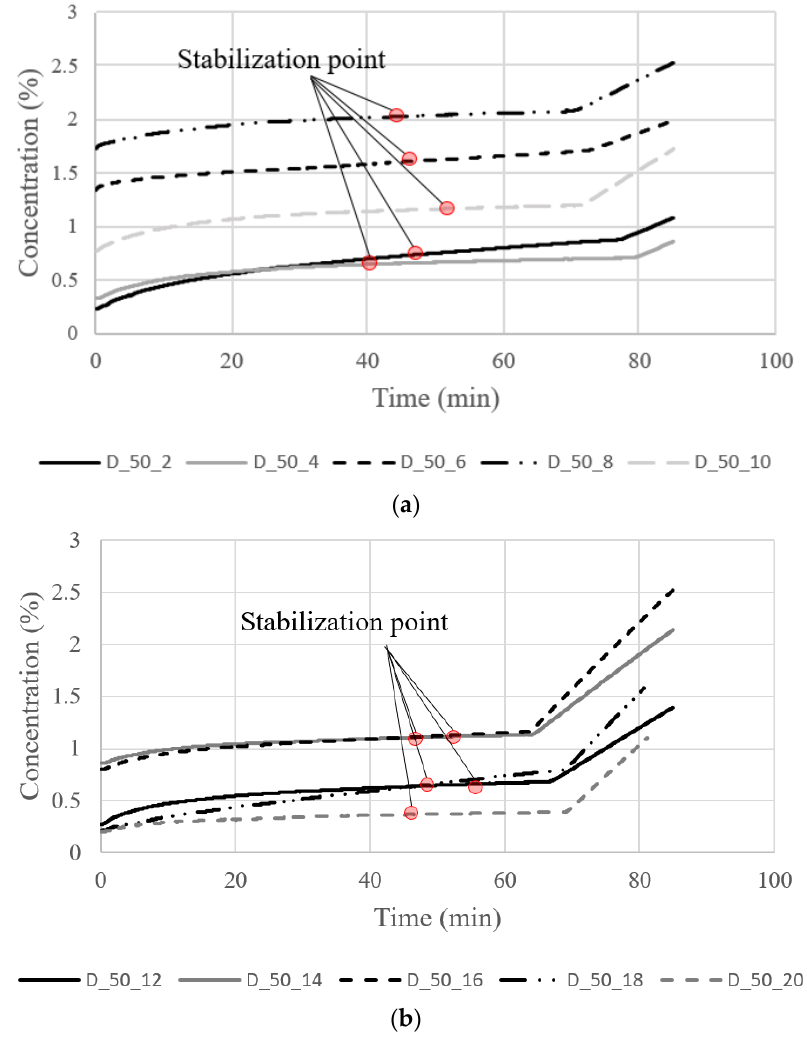
Figure 8. Concentration change in experimental equipment: ( a ) D_50_2 – 10; ( b ) D_50_12 – 20. Despite pre-stabilization, a relatively rapid change is considered to occur in the observation period within 20 min because of the difference between the final concentration of oxygen in the specimen and the initial concentration of the diffusion test. However, the measured oxygen concentration converged linearly within 1 h for all samples. The coefficient of determination is at least 0.98, which indicates that the diffusion between the test device and the test specimen has reached a steady state. The crack diffusion coefficients were calculated using Equations (1) and (3) based on the measured concentration data. Following, the crack widths for specimens D_25 and D_50 were estimated using Equation (2) with the measured crack diffusion